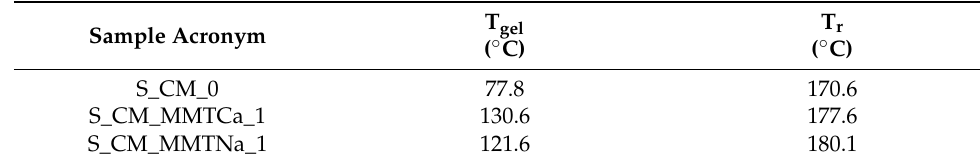
Table 1. Temperature values of non-revisable transitions.